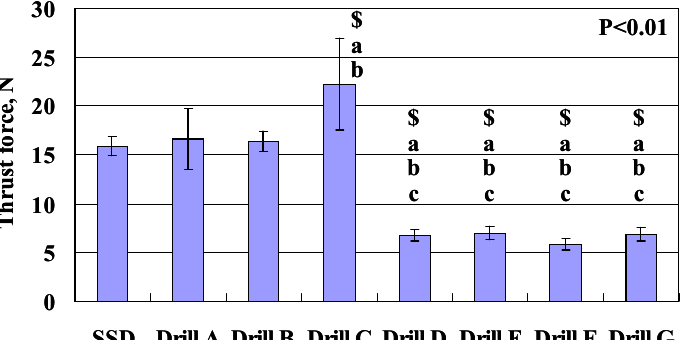
Fig. 5 Thrust force of the experimental drills. $, a, b, and c are significantly different compared to the SSD, and drills A, B, and C, respectively.